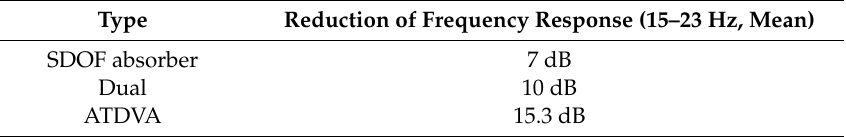
Table 1. Reduction of frequency responses due to vibration absorber